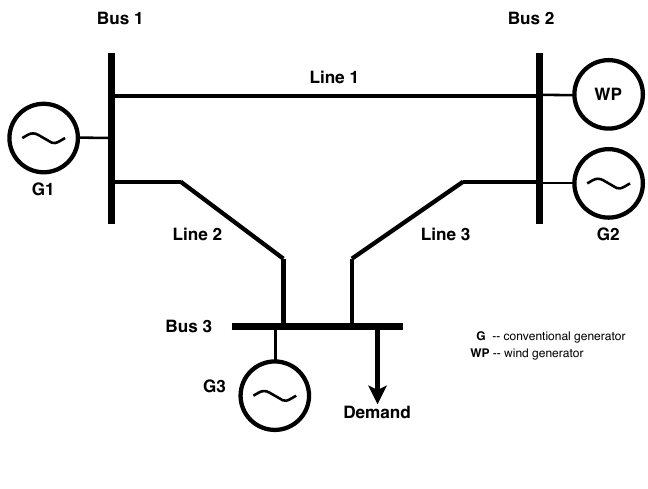
Figure 8. IEEE-3 bus test